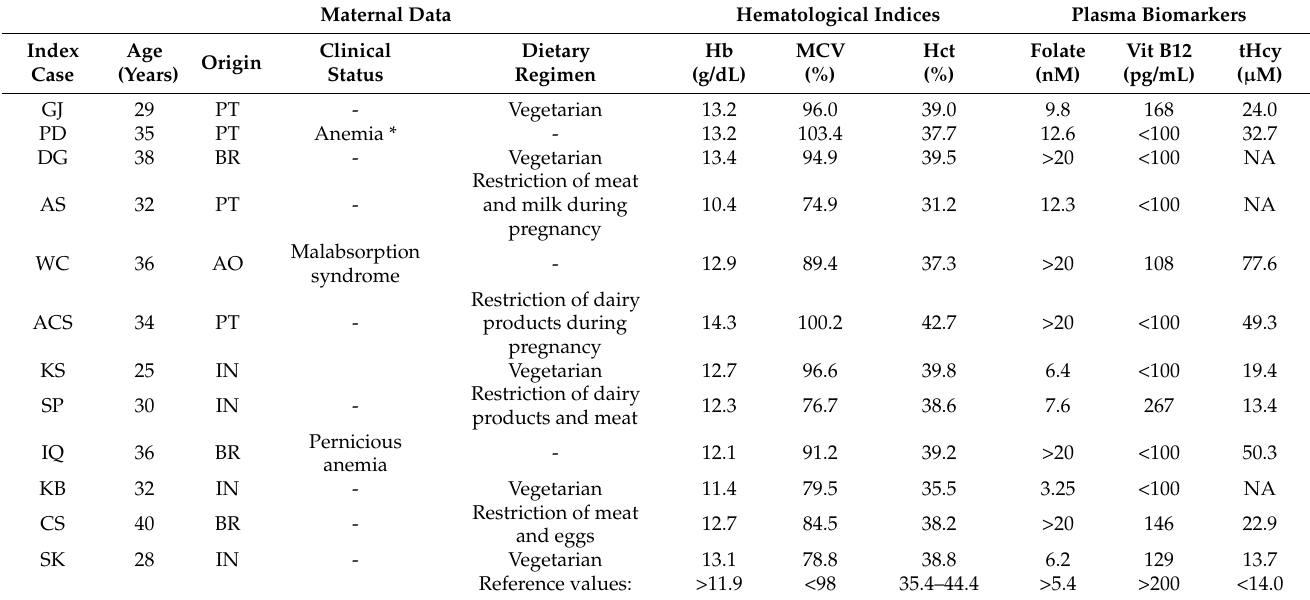
Table 3. Maternal demographic and clinical findings, dietary regimen, and biochemical